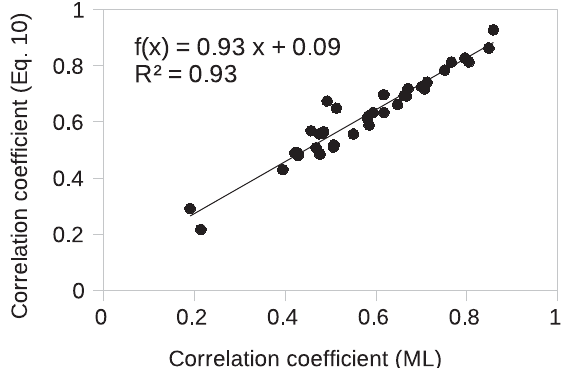
FIG. 6. Values of the correlation coefficient using Eq. (7) as a function of its value using the maximum likelihood method.